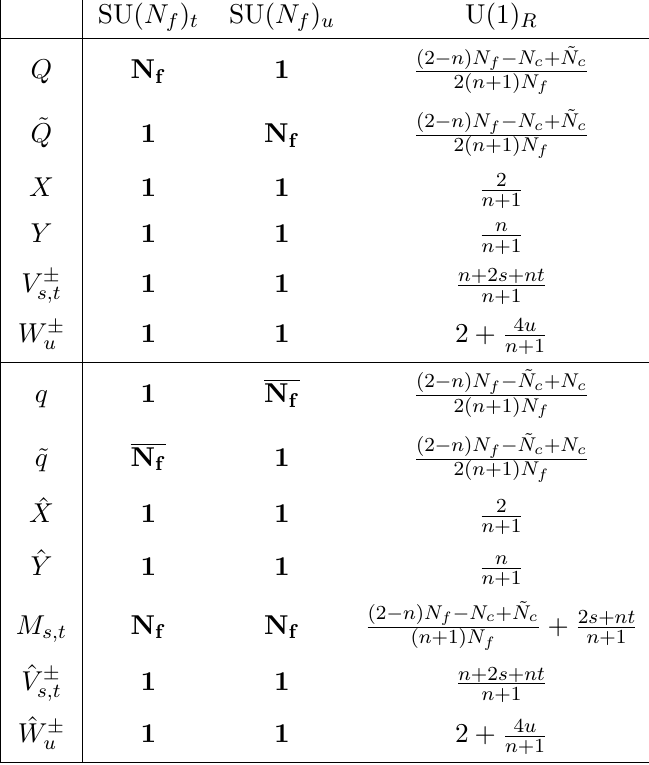
Table 6 . The representations of the chiral operators under the global symmetry groups of the double adjoint theory with the linear monopole superpotential ∆ W = W + + W − and its dual. The A 0 0 ˆ monopole operators ( V ± ) and ( ˆ V ± ) are presented together with the elementary fields in , W ± , W ± s,t s,t u u the upper box and the lower box respectively. Note that ˜ N is the dual gauge rank, which is defined c by ˜ N = 3 nN 2 n + 2 c f − N c −